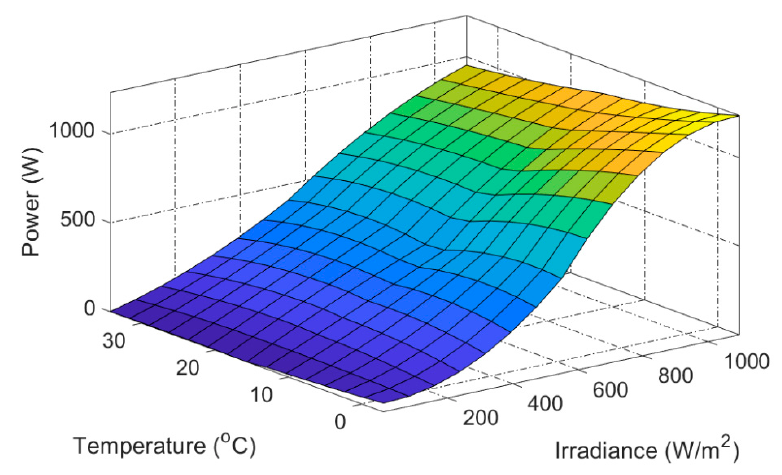
Figure 9. A surface between inputs irradiance and temperature vs PV power.